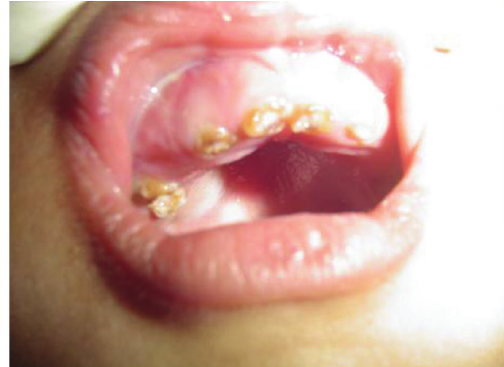
Figure 2: Intraoral photograph showing yellowish discolouration and chipping of the dentition.